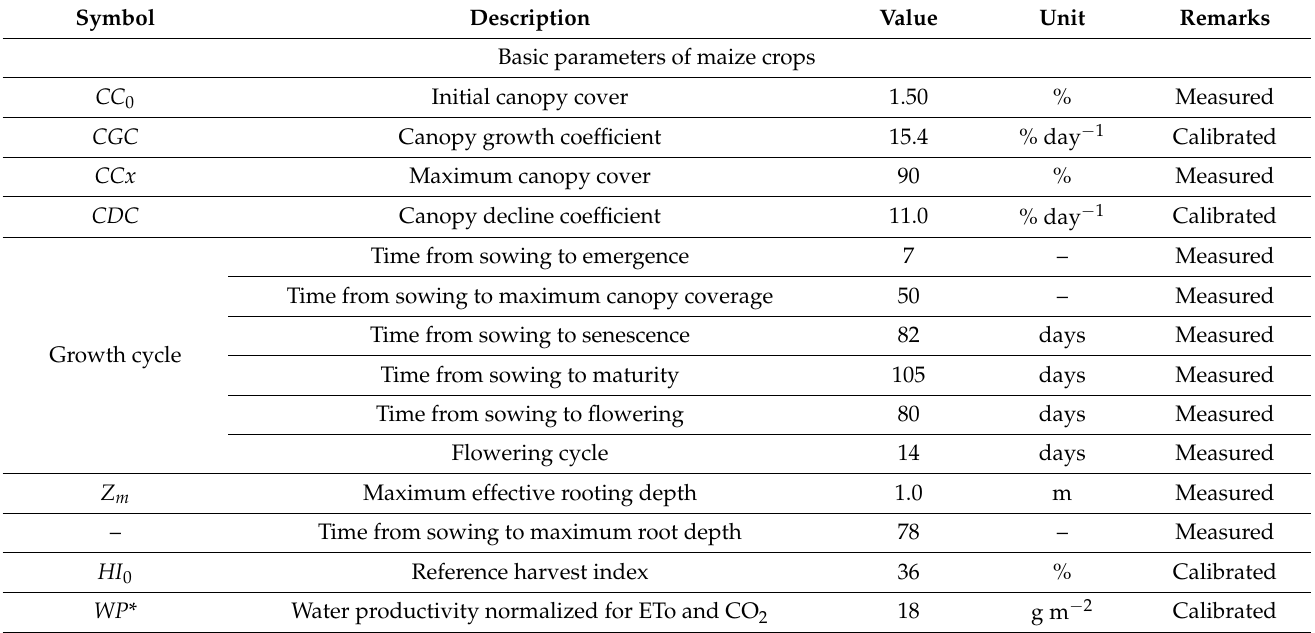
Table 2. Crop parameters of the AquaCrop